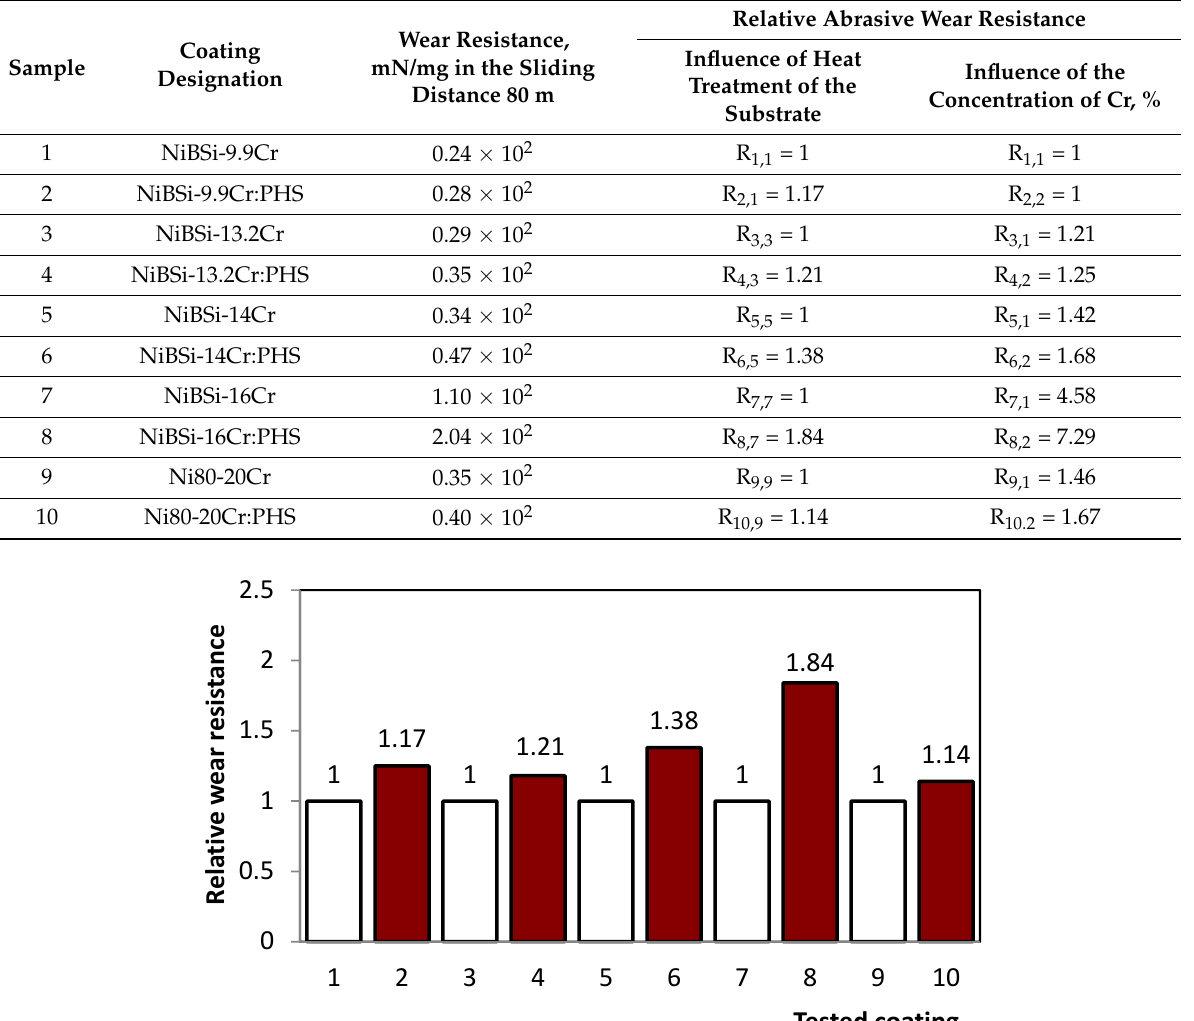
Table 4. Relative abrasive wear resistance of the tested coatings.